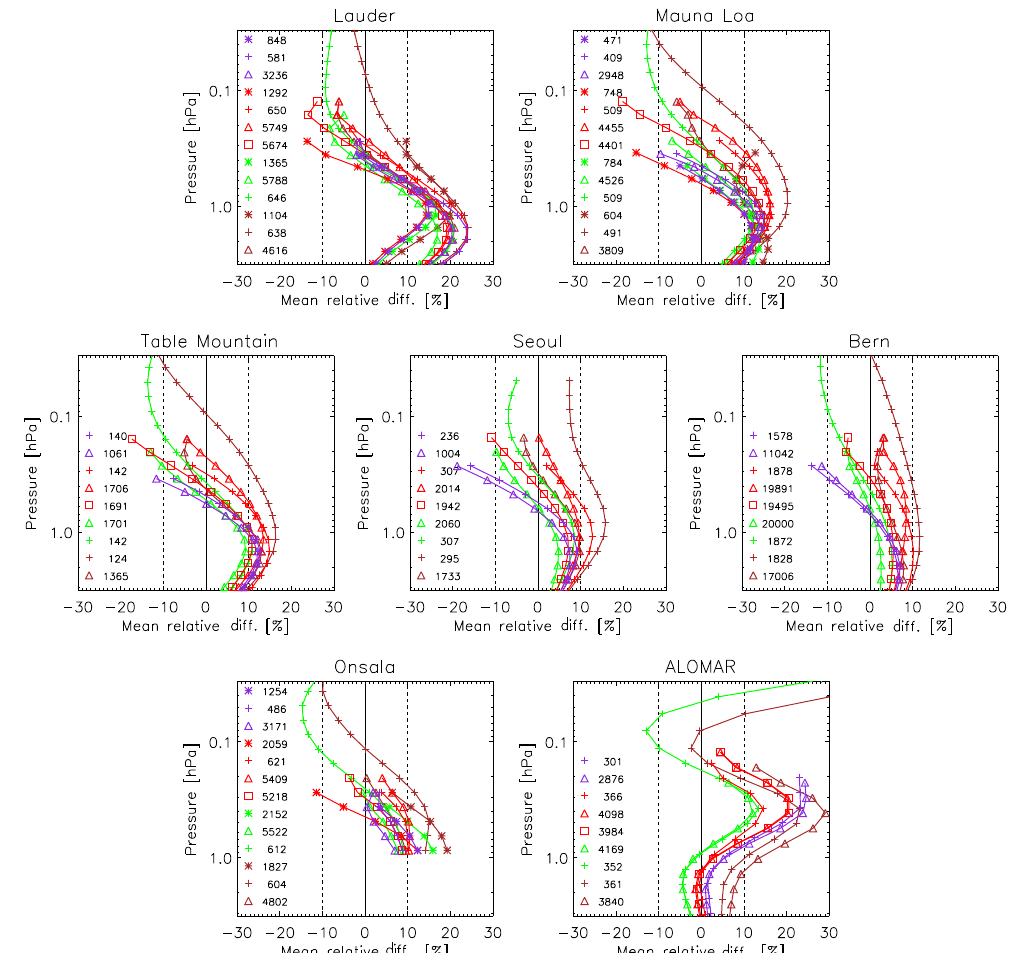
Figure 4. Same as Fig. 3, only for comparisons between various MIPAS retrievals and ground-based measurements.